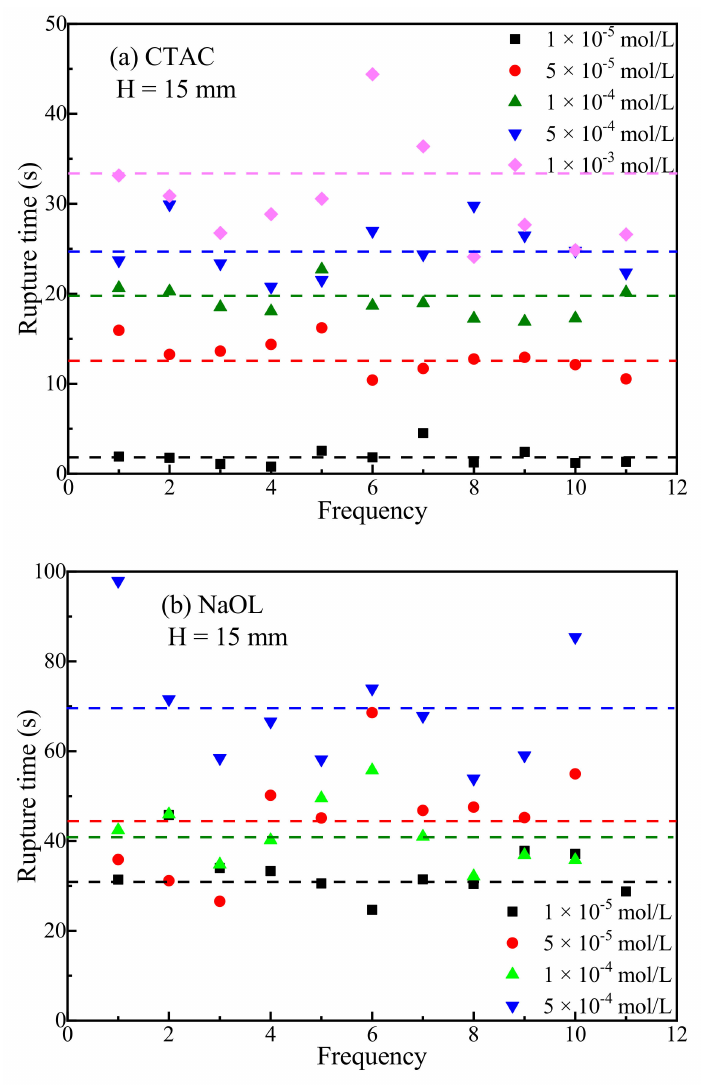
Figure 5. Bubble rupture time in ( a ) CTAC and ( b ) NaOL solutions with different concentrations. Table 2. Bubble rupture time in different surfactant solutions at H = 15 mm (s).